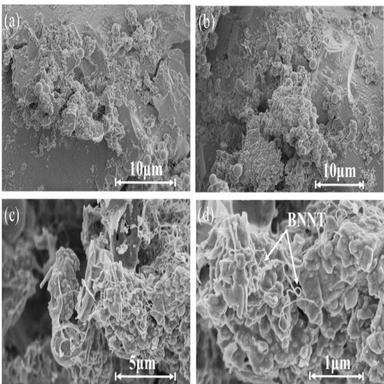
SEM images of the BNNT reinforced SiCN sample, with the scale bars of (a) 10 μ m, (b) 10 μ m, (c) 2 μ m, and (d) 1 μ m with highlighted BNNT.